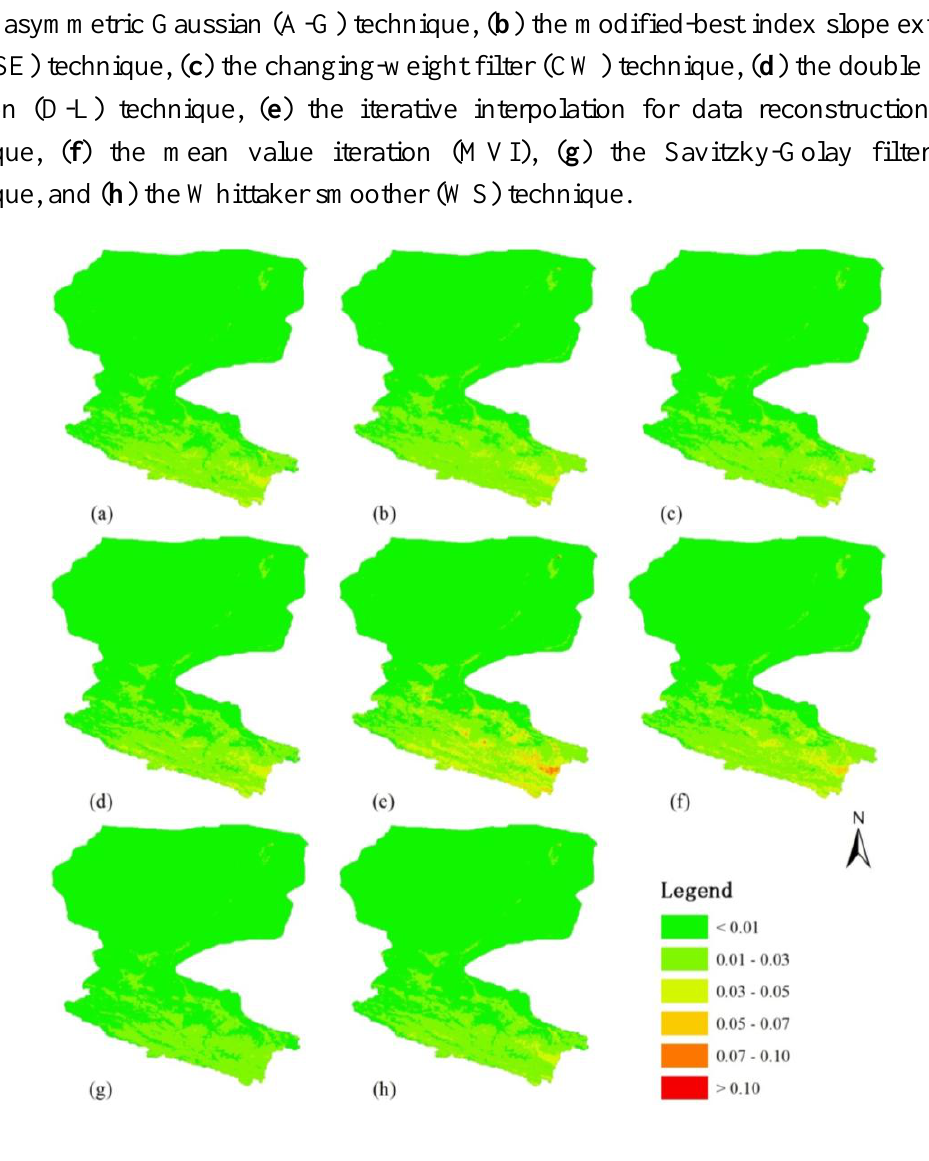
Figure 9. Root mean square error (RMSE) of MODIS NDVI for the eight